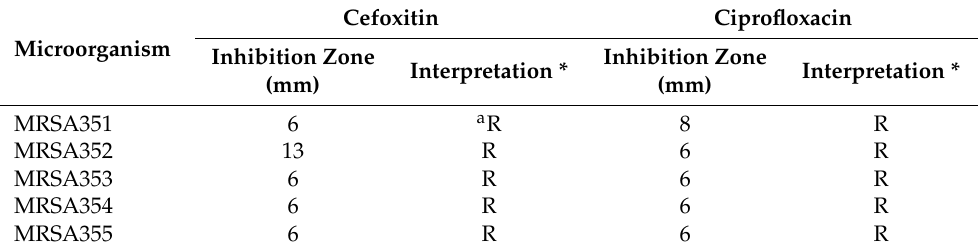
Table 3. Detection of MRSA strains with cefoxitin and